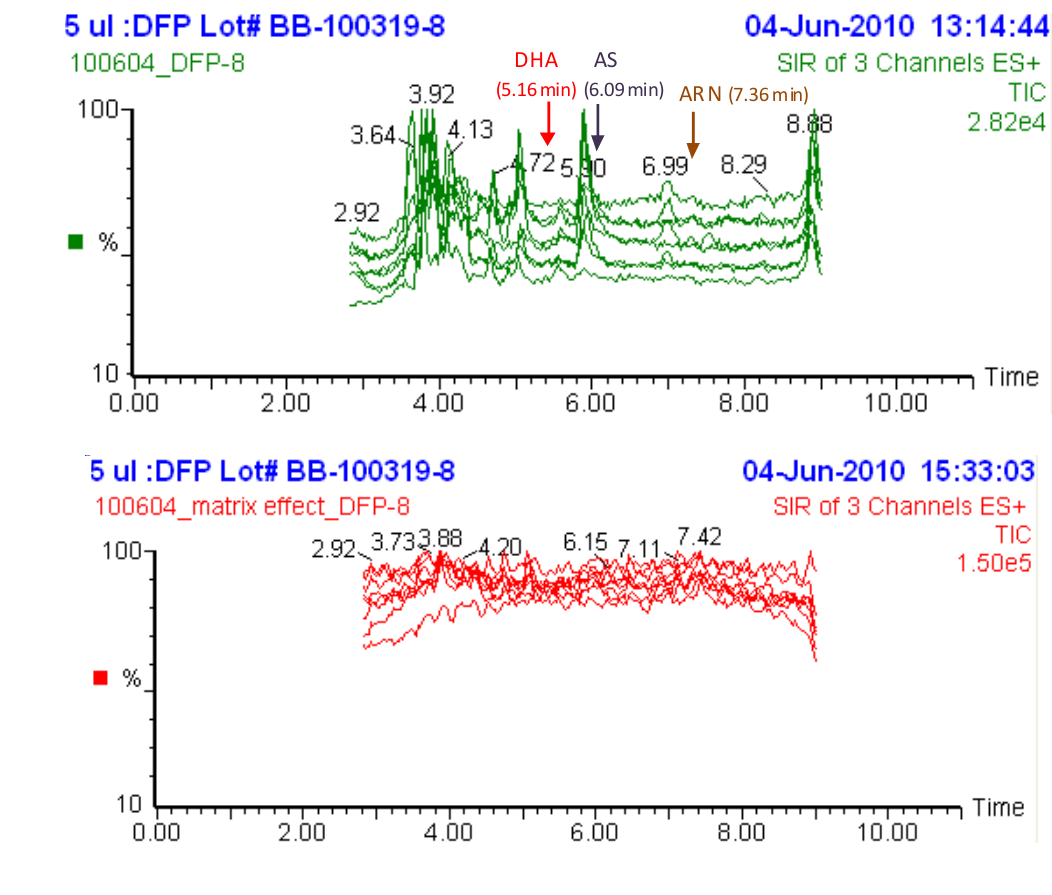
Values are average of six replicates for intra-assay test and triplicates per day for six different days of inter-assay test. Figure 4. ( a ) Chromatograms of blank plasma from eight healthy volunteers. ( b ) Post- column infusion of 100 nM of AS, DHA and 200 nM of ARN at 10 µL/min during injection of blank plasma extract from the same